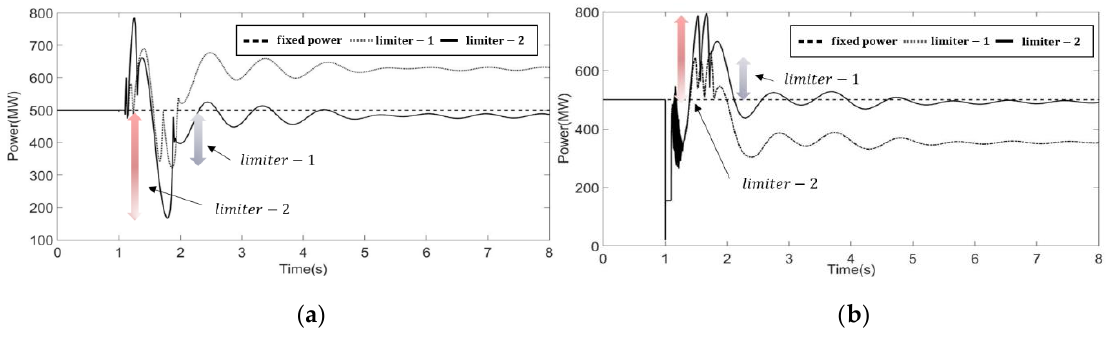
Figure 11. Active power of BTB VSCs, ( a ) left side fault ( 𝜃 𝑦 ) , and ( b ) right side fault ( 𝜃 𝑥 ) .